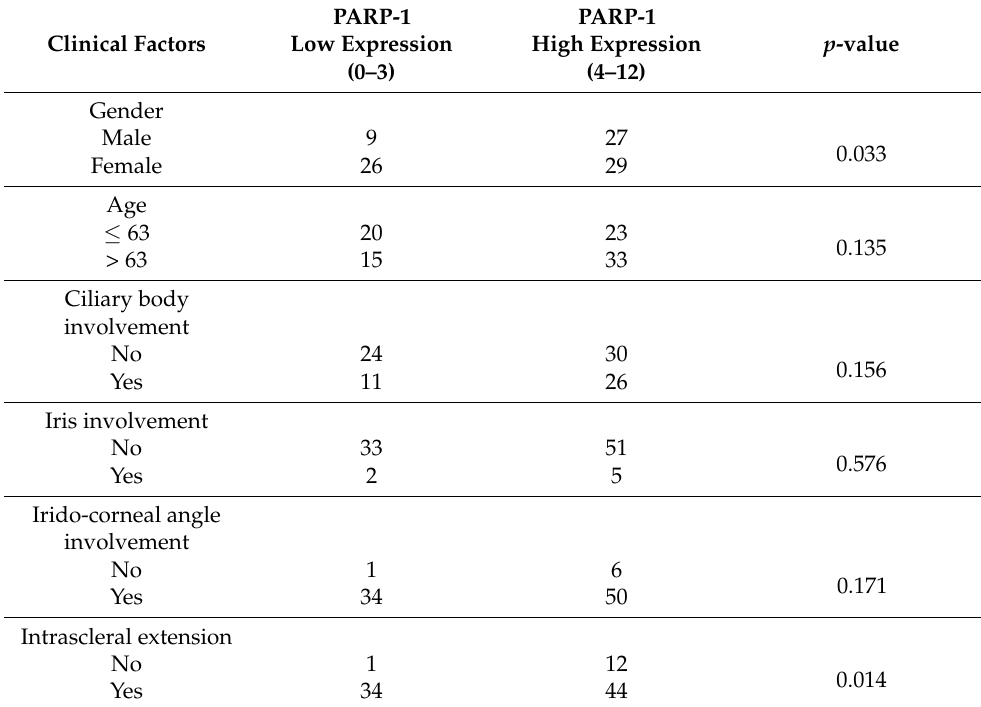
Table 2. Associations of PARP-1 total expression with clinicopathological parameters in uveal melanoma